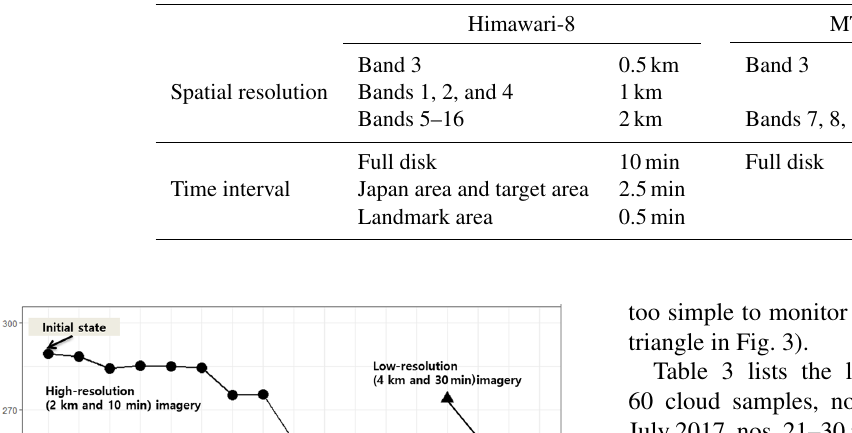
Table 2. Spatial resolution and the time interval of the Advanced Himawari Imager (AHI) for Himawari-8 and the MTSAT-1R/2 Imager (images from the JMA/MSC; Himawari-8/9 Imagery (AHI), 2018).